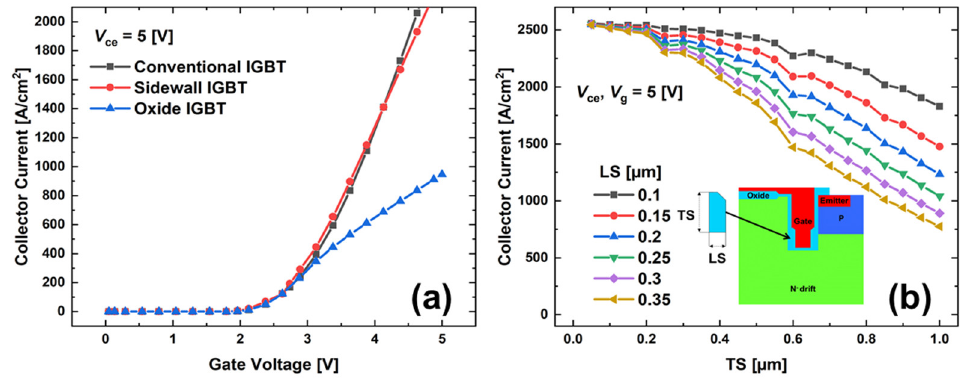
Figure 3. ( a ) I c - V g characteristic curves of the C-IGBT, S-IGBT and O-IGBT. ( b ) Collector current according to the sidewall spacer parameters.